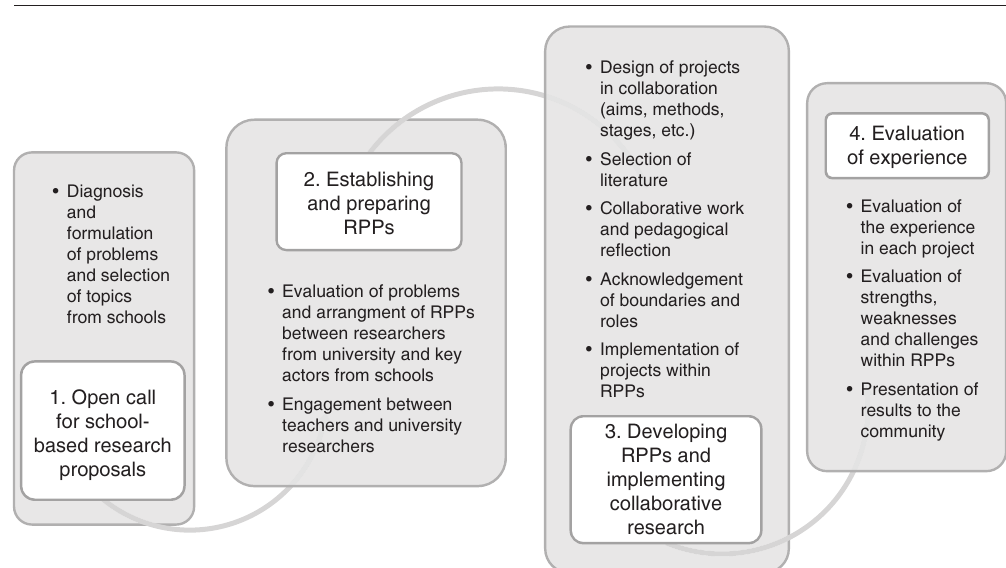
Figure 3: Research–practice partnerships and collaborative research